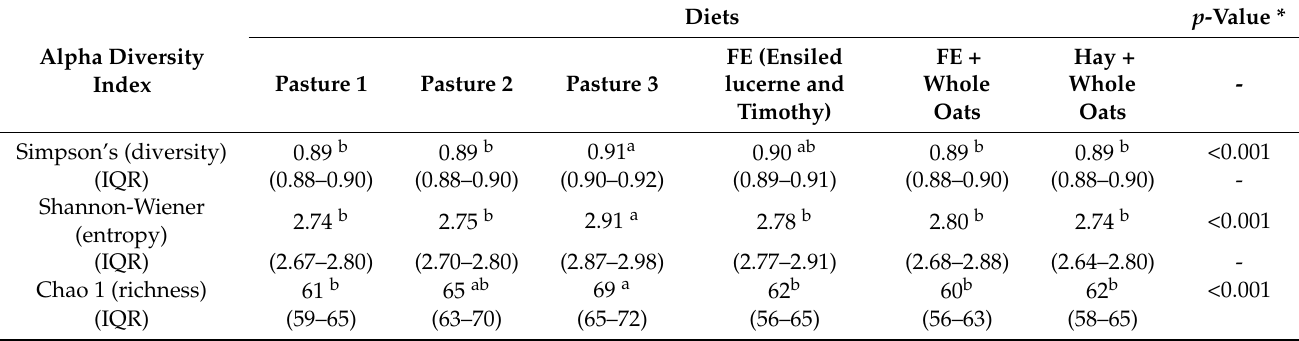
Table 3. Comparison of the median alpha diversity of the bacterial genera across